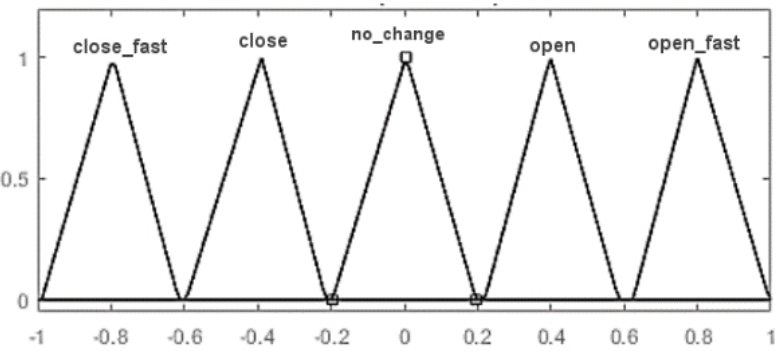
Figure 9. Membership functions for the “valve” output variable.